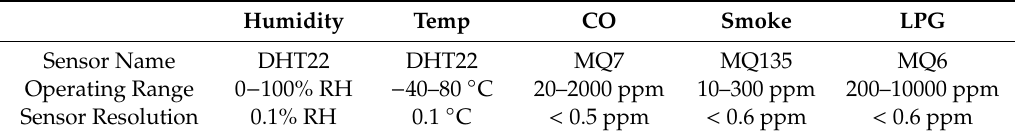
Table 2. Sensor Table 2. Sensor specifications.